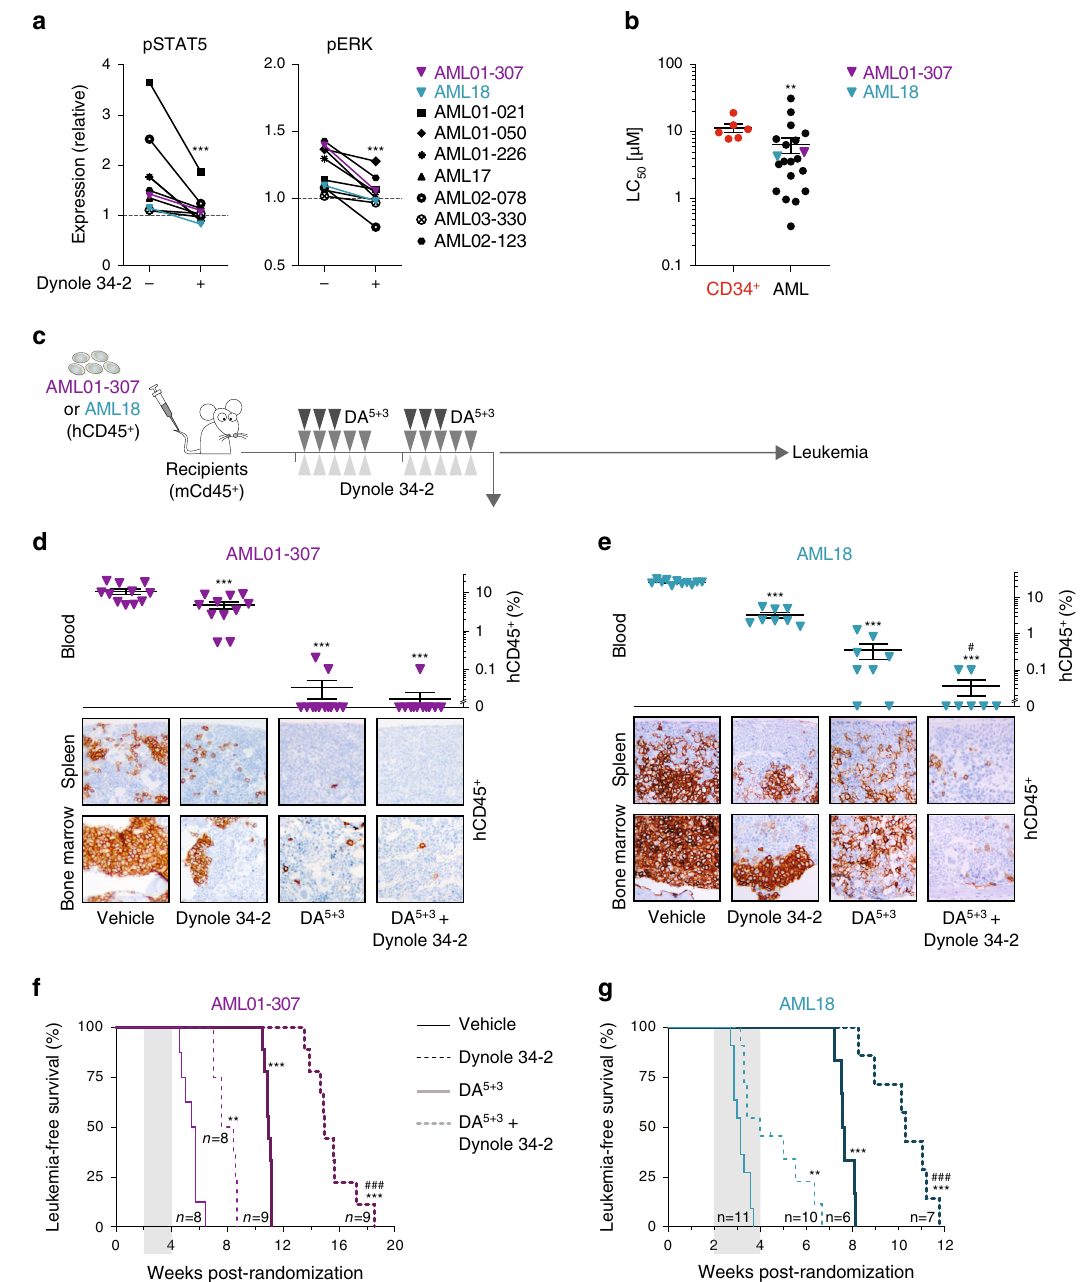
Fig. 7 Dynole 34-2 exhibits activity in human AML. a Relative levels of activated STAT5 (pSTAT5, left) and ERK (pERK, right) in patient-derived AML cells treated with vehicle and Dynole 34-2, after in vitro stimulation with IL-3 (left) and SCF (right). AML01-307 is depicted with solid purple triangles, AML18 with solid turquoise triangles, and all other AML samples in black. Levels in unstimulated xenograft cells treated with vehicle were used as control, and reported as 1 (dashed line). Mean± SD, two-way ANOVA with Bonferroni correction test; ** P < 0.01 and *** P < 0.001 as compared to vehicle ( N = 14 primary AML, performed in duplicate). b Median lethal concentration (LC 50 ) of Dynole 34-2 for patient-derived AML cells ( N = 22 leukemias), assessed by performing clonogenic assays for 10 days (Supplementary Fig. 9c, d). Human CD34-positive HSPCs (red dashed line; CD34 + ) from healthy donors ( N = 6) were used as controls. Mean± SEM, two-tailed Mann – Whitney test; ** P < 0.01 compared to CD34 + control cells. Each circle represNOTCH1, fraction of leukemic blasts harbouring activating mutations of NOTCH1ents an individual human sample. c , Experimental setting for testing the ef fi cacy of Dynole 34- 2, DA 5 + 3 and combination therapy in xenograft models of human AML. Sublethally irradiated NRGS recipients were randomized after engraftment was con fi rmed in the peripheral blood and subsequently treated when the average proportion of human leukemic cells in the peripheral blood reached 1%. d , e Proportion of patient-derived cells (%hCD45 + ) in the peripheral blood (top), as well as immunochemistry against hCD45 + leukemic cells in the bone marrow and spleen (bottom) of recipients injected with AML01-307 ( d ) and AML18 ( e ), 24 h after the last drug injection. Scale bars: 10 μ m. Mean ± SEM, two-way ANOVA with Tukey ’ s correction test; *** P < 0.0001 compared to vehicle; # P < 0.05 and ### P < 0.0001 compared to VXL. Each triangle represents an individual recipient. f , g Kaplan – Meier curves of sublethally irradiated recipients injected with AML01-307 ( f ) and AML18 ( g ), administered with either vehicle or Dynole 34-2, as a single a g ent or in combination with DA 5 + 3 chemotherapy. Log-rank (Mantel – Cox) test; *** P < 0.0001 compared to vehicle; ### P < 0.0001 compared to DA 5 + 3 . The period of administration is indicated in light grey, with the number of recipients for each cohort